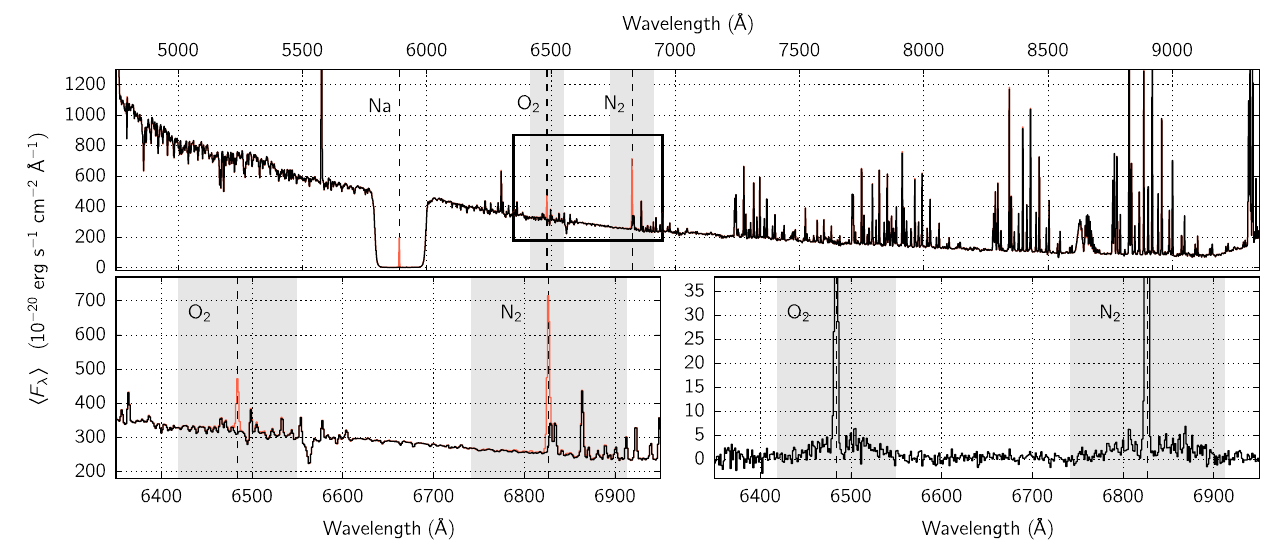
FIG. 1. Top panel: Mean MUSE spectra [in the WFM-nominal (WFM-N) setup] constructed from a 60-s exposure on an empty sky field at an air mass of around 1.8, with and without the 4LGSF lasers propagating (red and black curves, respectively), under full-moon conditions. In addition to the residual laser line (visible through Rayleigh and Mie scattering in the laser beams) at λ 4 spectral features resulting from the inelastic Raman scattering of laser photons by the O 2 and N 2 photons are present at 6484.39 Å and 6827.17 Å (respectively) when the 4LGSF lasers are propagating. Bottom left panel: Same as top panel, but zooming in on the 6350 Å — 6950 Å spectral range. Bottom right panel: Difference between the spectra of the top panel, revealing the rotational wings (i.e., the S branch and the O branch) surrounding the central vibrational peak (i.e., the Q branch) of the Raman lines for both the O 2 and N 2 molecules. The spectral extent of the Raman contamination (including both the vibrational central peak and rotational sidebands) is traced using greyed-out areas in all panels. The box in the top panel shows the extent of the bottom